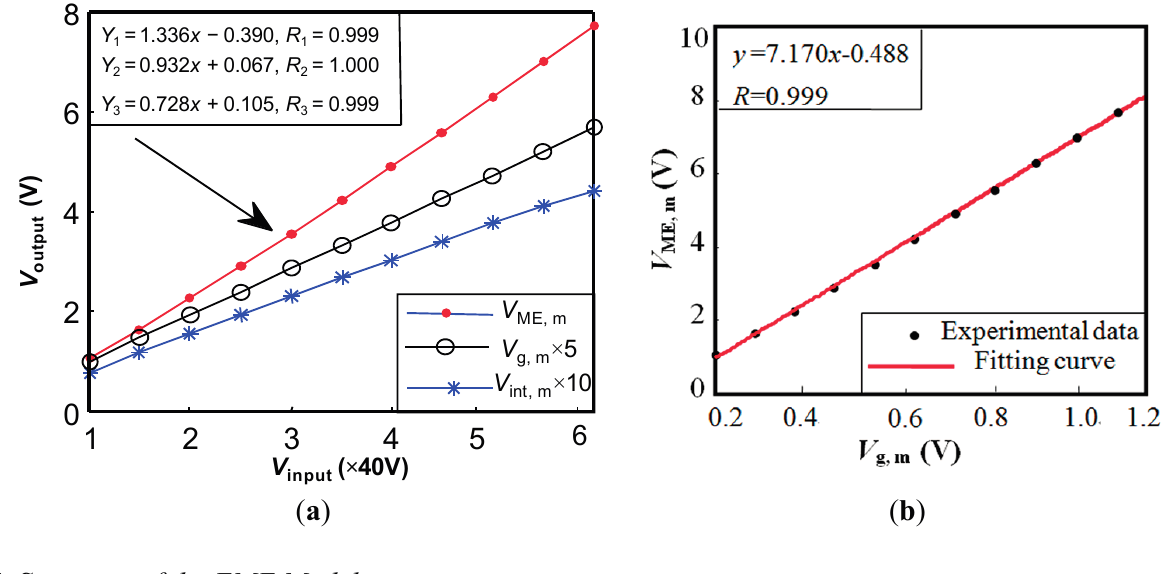
Figure 7. The performance tests of the ME sensing unit under pulse excitation: ( a ) The ; and ( b ) The measured results by three methods under different input voltages V input and V . V is the peak value of V output from the ME sensing relationship of V ME g, m ME, m ME represents the maximum value of the integral of the induced voltage output unit. V int, m denotes the peak value of the signal from a from a secondary coil. V g, m